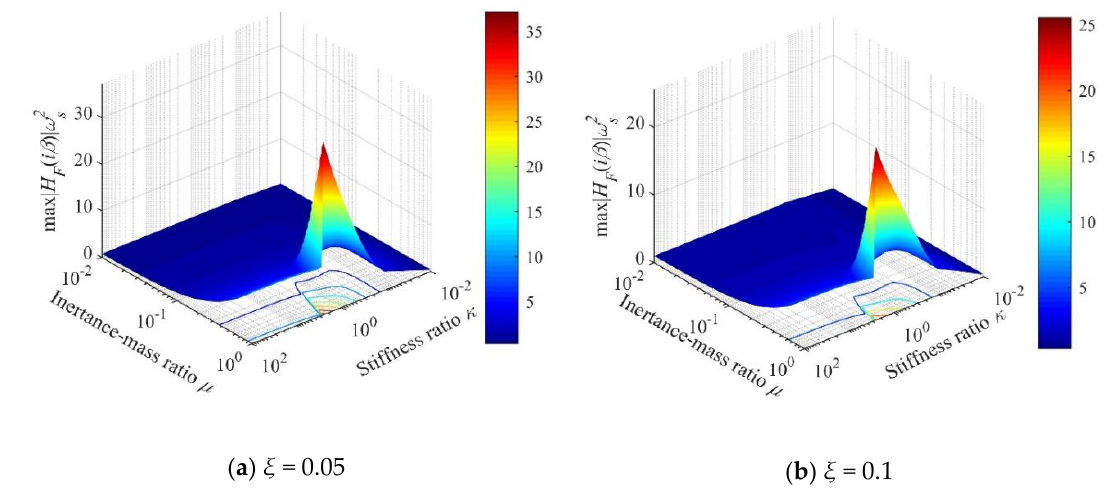
Figure 7. Force amplification factor of the inerter system.